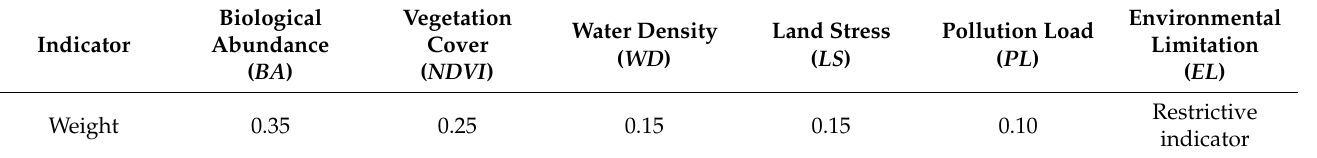
Table 2. Indicators and their weights of EI .